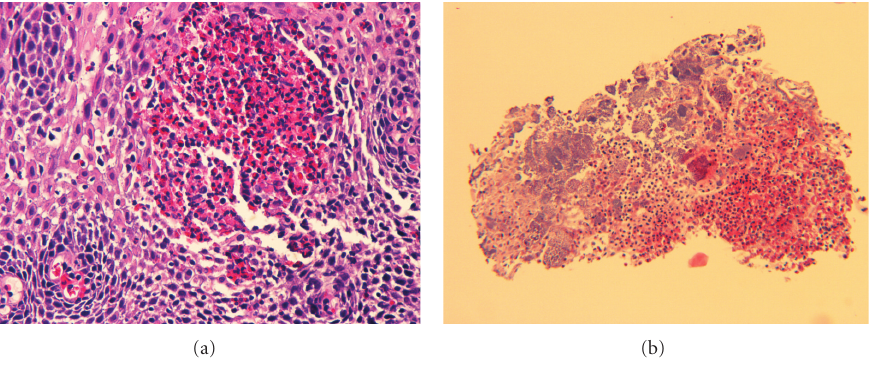
Figure 2: Biopsy revealing eosinophils in the